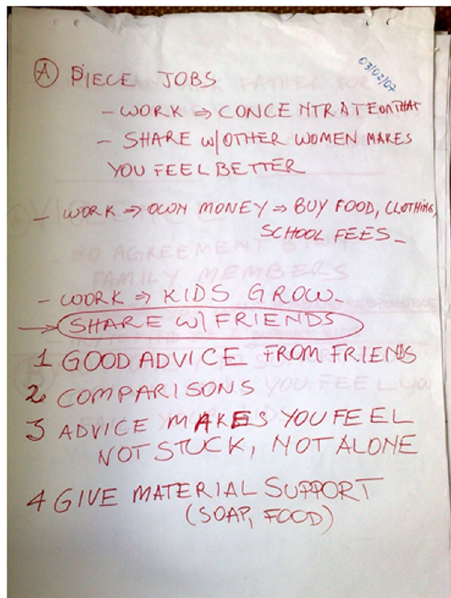
Fig. 2 Brainstorming session. Flipchart recording participants ’ associations with the word ‘ happiness ’ during the brainstorming session of a focus group